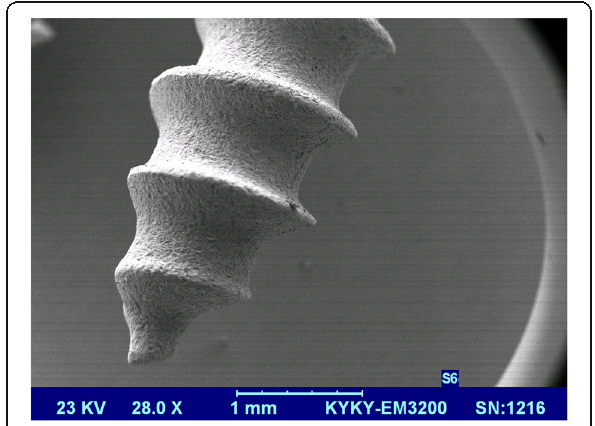
Fig. 2 Scanning electron microscope images of miniscrews in the sandblasted and acid-etched